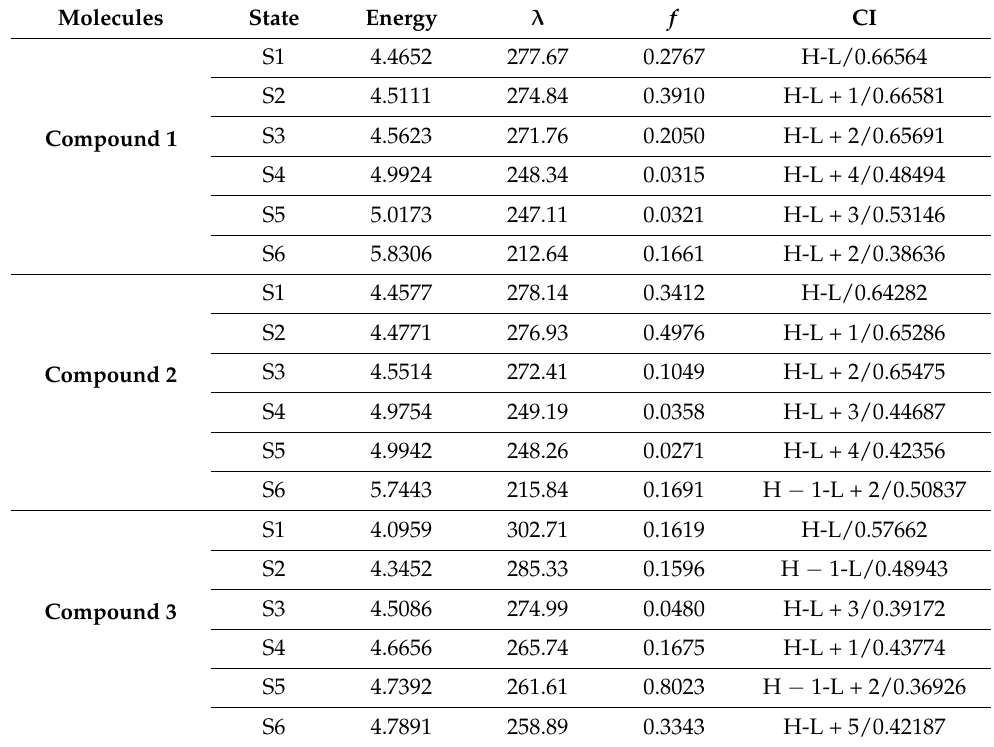
Figure 8. The computed UV–Vis absorption spectra of the compounds. Table 4. The vertical excitation energy (eV), absorption peak (nm), configuration interaction (CI) coefficient and oscillator strengths ( f ) of investigated molecules.